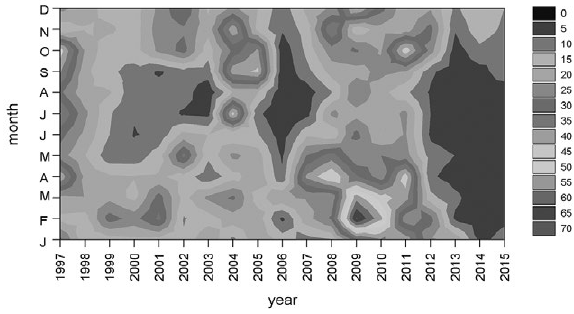
Fig. 3. – Loligo vulgaris . Seasonal and interannual variability of the Fig. 6. – Loligo vulgaris . Annual average and standard deviation of official landings of squid (kg) in the whole Ría de Vigo (fish markets official landings of squid (10 3 kg) in the whole Ría de Vigo (fish of the ports of Baiona, Canido, Cangas, Moaña, Panxón and Vigo) markets in the ports of Baiona, Canido, Cangas, Moaña, Panxón between 1997 and 2015. and Vigo) and in the Ría de Vigo after adding the Aldán-Hío and Bueu fish markets and subtracting the data from the fish market of the port of Vigo,